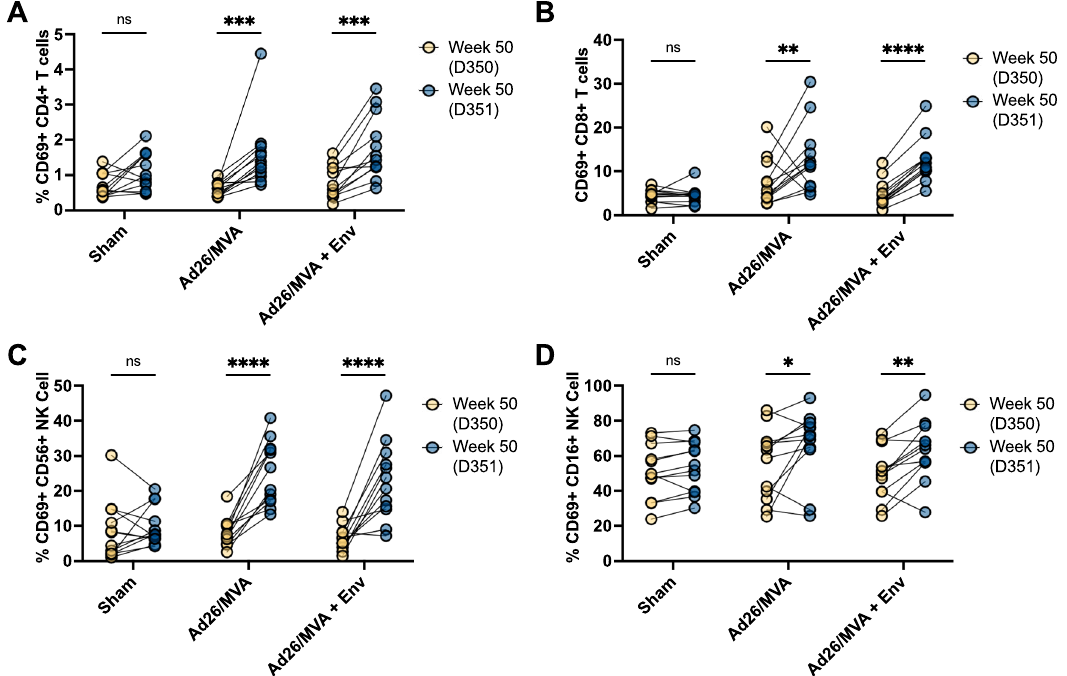
Fig. 3 Cellular activation following vesatolimod administration. A – D T and NK cell activation in both sham and vaccinated groups as measured by increase in cell surface CD69 + expression one day following vesatolimod administration at week 50 post-infection in CD4 + T cells ( A ), CD8 + T cells ( B ), CD56 + NK Cells ( C ), and CD16 + CD56- NK Cells ( D ). Statistical signi fi cance determined from two-way ANOVA with Bonferroni correction for multiple comparisons. * < 0.05, ** < 0.01, *** < 0.001, **** <